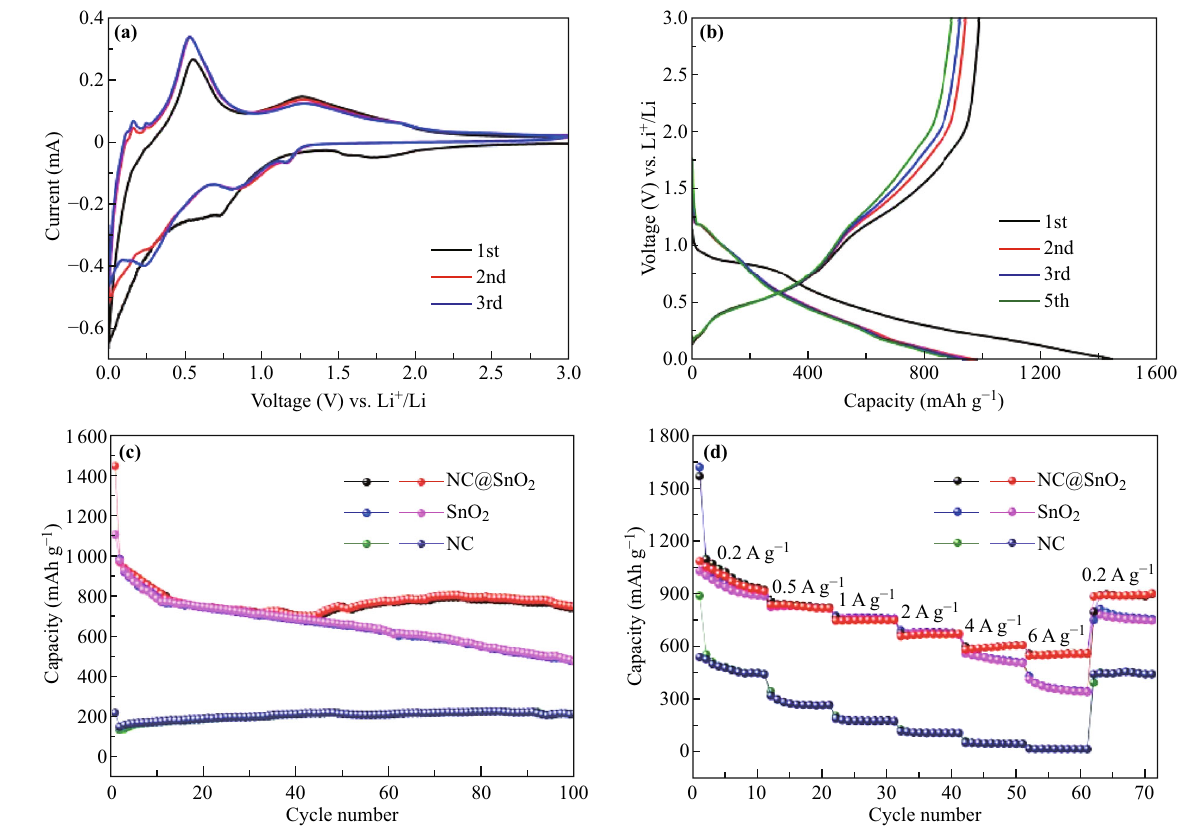
Fig. 5 Electrochemical performance for LIBs: a Cyclic voltammetry curves of NC@SnO 2 at 0.1 mV s - 1 . b Charge–discharge voltage profiles of NC@SnO 2 . c Cycling performances of NC@SnO 2 , SnO 2 , and NC at 1 A g - 1 . d Rate capabilities of NC@SnO 2 , SnO 2 , and NC. (Color figure